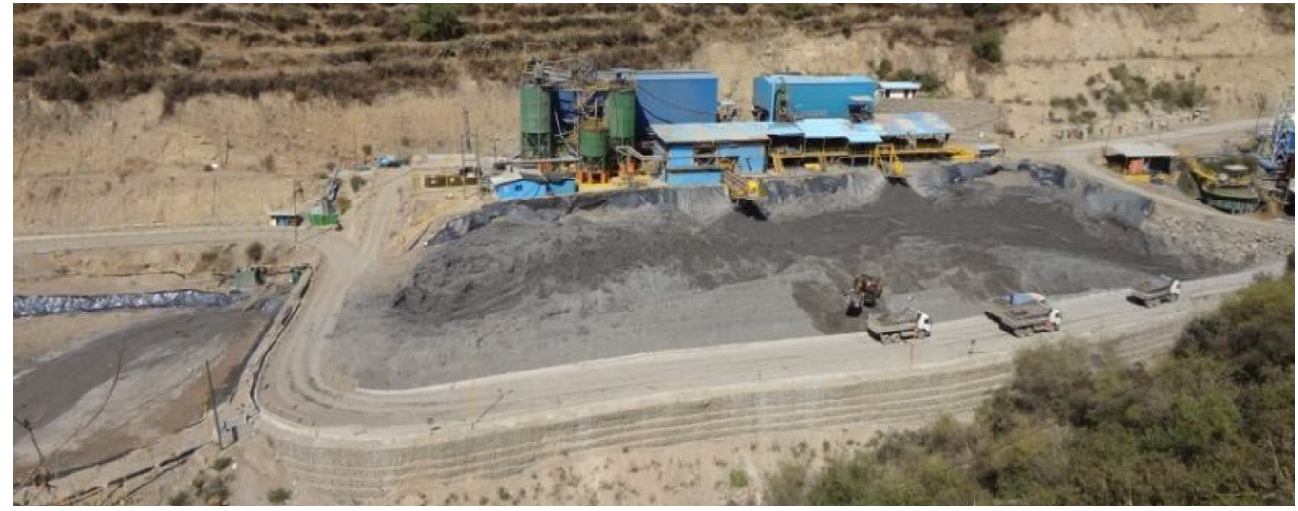
Figure 68. Ramahuayco Filtering Plant [40,41].